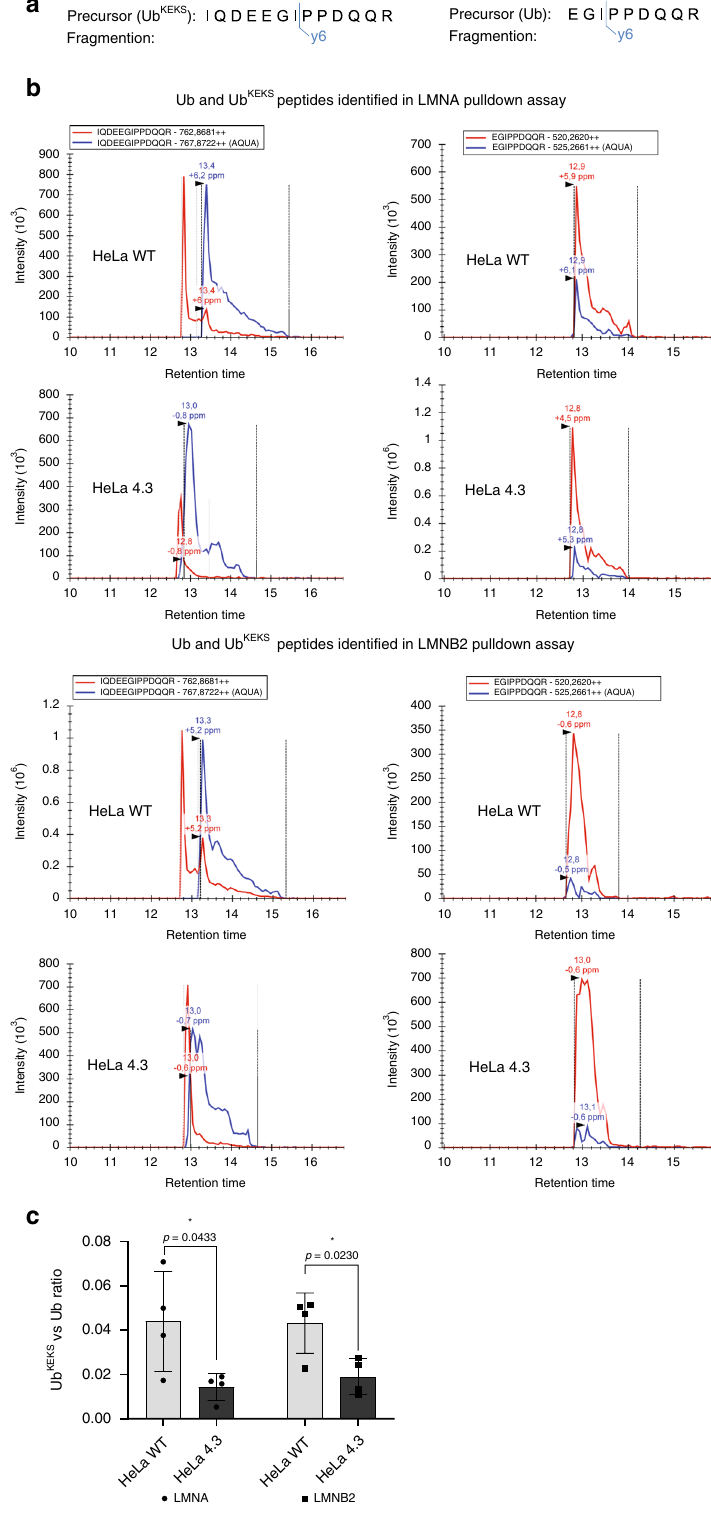
Fig. 5 Quanti fi cation of Ub and Ub KEKS in lamin A and lamin B2 pulldown assay. a Precursors and their fragment ions used for quanti fi cation of Ub and Ub KEKS . b Fragment ion chromatogram of Ub and Ub KEKS in WT and Ub KEKS KO (clone 4.3) HeLa cells in lamin A (LMNA) and lamin B2 (LMNB2) pulldown assays. Blue line represents heavy (AQUA) peptide, red line represents endogenous peptides with m/z values indicated in the box above chromatograms. Dotted lines indicate peak boundaries with black arrows showing peaks. Peak values with mass error are indicated above each peak. c Ratio of Ub KEKS to Ub in WT and Ub KEKS KO (clone 4.3) HeLa cells in LMNA and LMNB2 pulldown assays. Data are presented as mean values ± SD; individual data points are superimposed on the bar graph. Statistical analysis was performed using unpaired two-tailed t -test ( n = 4 independent experiments). Source data are provided as a Source Data fi